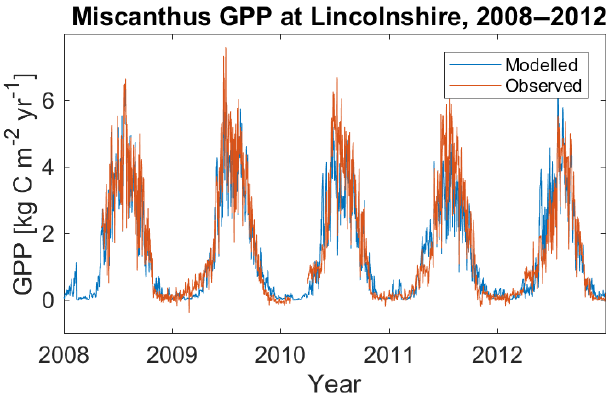
Figure 3. Modelled gross primary productivity of Miscanthus , com- pared against observations at Lincolnshire, UK, for the period